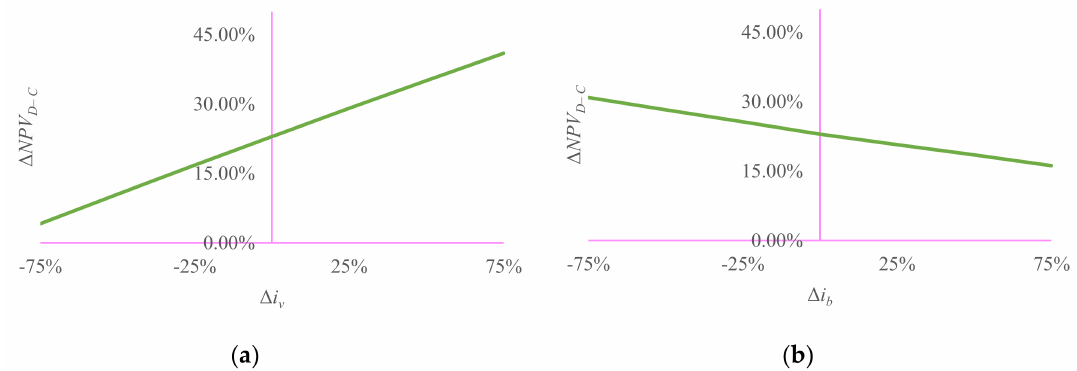
Figure 5. Sensitivity analysis for different interest rates: impact on ∆ NPV D–C while varying ∆ i v ( a ) and while varying ∆ i b ( b ).